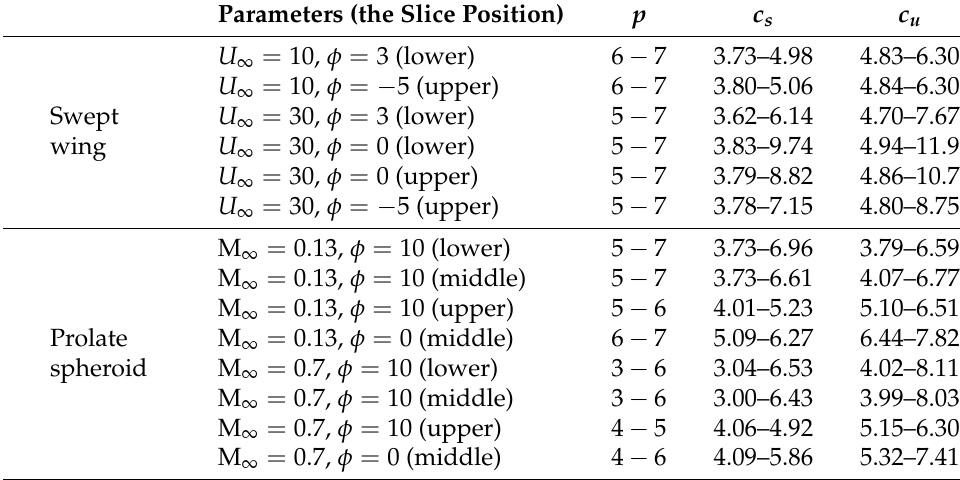
( tol ) for the swept wing (at different values of U ∞ [ m / s ] Table 1. Adequate ranges of p = − log H 10 and φ [ ◦ ] for different 2D slices) and for the prolate spheroid (at different values of M ∞ and φ [ ◦ ] for different 2D slices) and corresponding ranges of optimal constants c s , c u . The considered slices are located on the lower or upper sides of the wing, and on the lower, middle and upper parts of the prolate